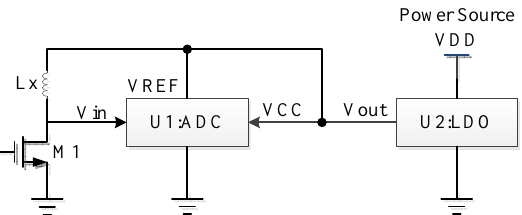
Figure 4. Block diagram of the ADC and LDO circuit (we propose methods to reduce the influence of the